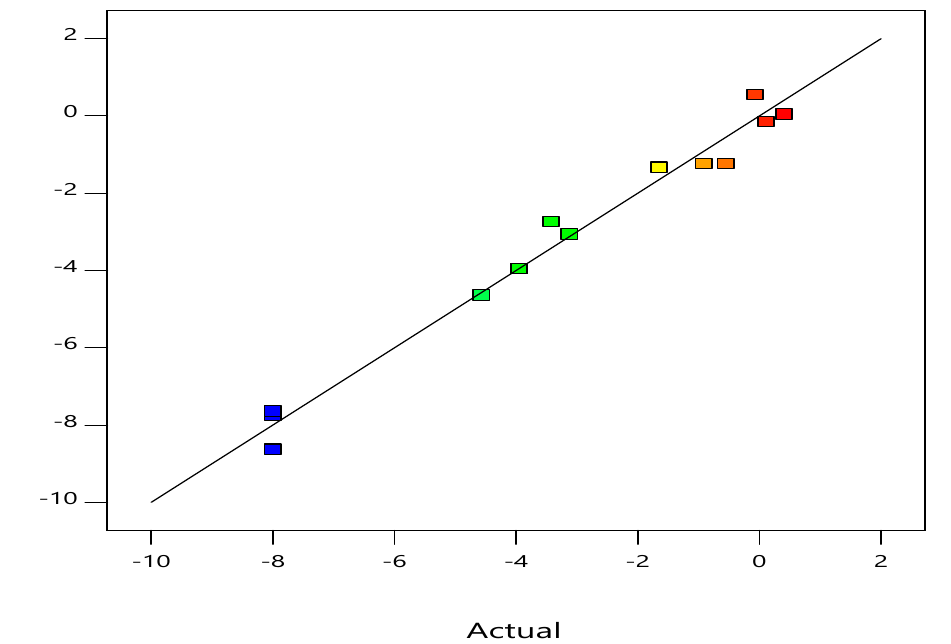
Figure 1. Relationship between the response surface model’s predicted and actual values for E. coli inactivation.